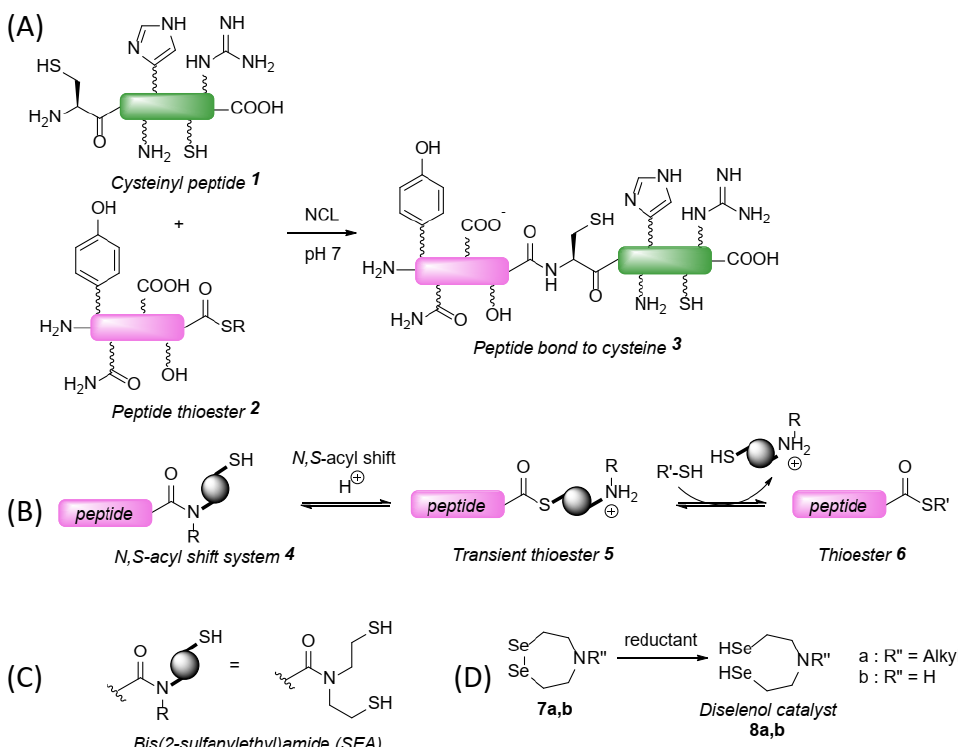
Figure 1. ( A ) Principle of the native chemical ligation (NCL). ( B ) N , S -acyl shift amide systems rearrange into thioesters in aqueous solution and can be used for producing stable thioesters by exchange with a thiol. ( C ) The bis (2-sulfanylethyl)amide (SEA) system. ( D ) Selenol catalysts reported by Cargoët et al.